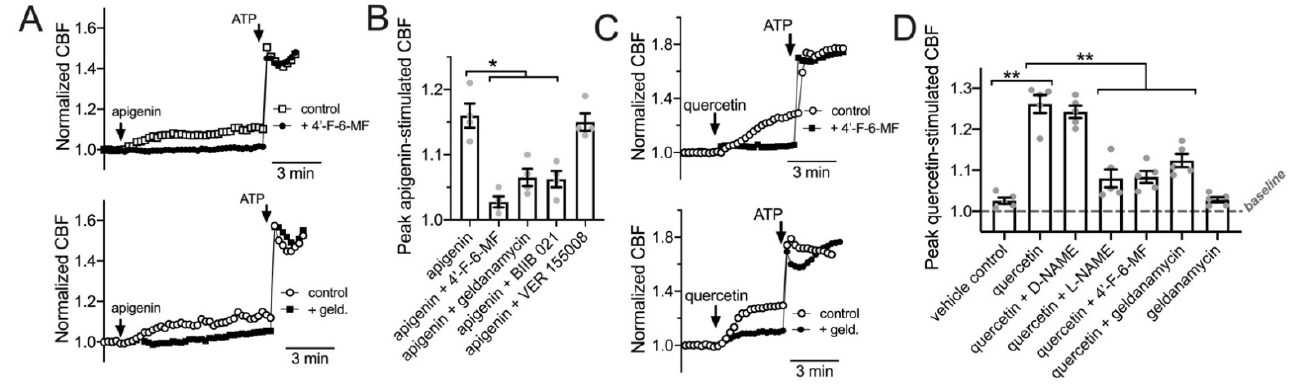
Figure 6. HSP90 inhibition reduces T2R-stimulated ciliary beating in primary sinonasal epithelial cells. ( A ): Left shows representative normalized CBF responses (representative experiments shown) to T2R14/39 agonist apigenin in human primary sinonasal ALIs ± T2R14/39 inhibitor 4 ′ -fluoro-6- methoxyflavanone. Right shows normalized CBF responses (representative experiments shown) to apigenin ± geldanamycin (10 µM; 5 min pretreatment). Mean baseline CBF was not with vehicle or 4 ′ -fluoro-6-methoxyflavanone pretreatment (7.5 ± 1.1 Hz or 8.2 ± 0.9 Hz, respectively; not significant by Students’ t -test). Mean baseline CBF was also not different before or after vehicle or geldanamycin pretreatment (6.9 ± 1.7 Hz or 7.9 ± 1.2 Hz, respectively; not significant by Students’ t -test). ( B ): Bar graph of the mean ± SEM of CBF responses from five independent experiments as shown in ( A ) using ALIs from four different patients. Significance determined by one-way ANOVA with Bonfer- roni post-test; * p < 0.05. ( C ): Left shows representative normalized CBF responses (representative experiments shown) to T2R14/39 agonist quercetin in human ALIs ± T2R14/39 inhibitor 4 ′ -fluoro-6- methoxyflavanone. Mean baseline CBF was not with vehicle or 4 ′ -fluoro-6-methoxyflavanone pre- treatment (7.3 ± 1.2 Hz or 7.9 ± 0.6 Hz, respectively; not significant by Students’ t -test). Right shows normalized CBF responses (representative experiments shown) to quercetin ± geldanamycin (10 µM; 5 min pretreatment). Mean baseline CBF was not different before or after vehicle or geldanamycin pretreatment (7.4 ± 1.3 Hz or 7.0 ± 0.9 Hz, respectively; not significant by Students’ t -test). ( D ): Bar graph of the mean ± SEM of CBF responses from five independent experiments as shown in C using ALIs from five different patients. Significance determined by one-way ANOVA with Bonferroni post-test; ** p < 0.01.